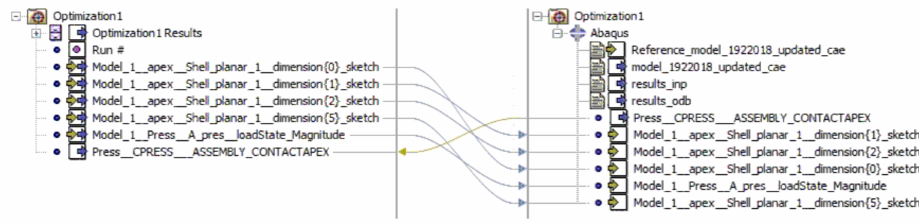
Figure 11. Optimization dataflow. Table 5. Not feasible designs from optimization.